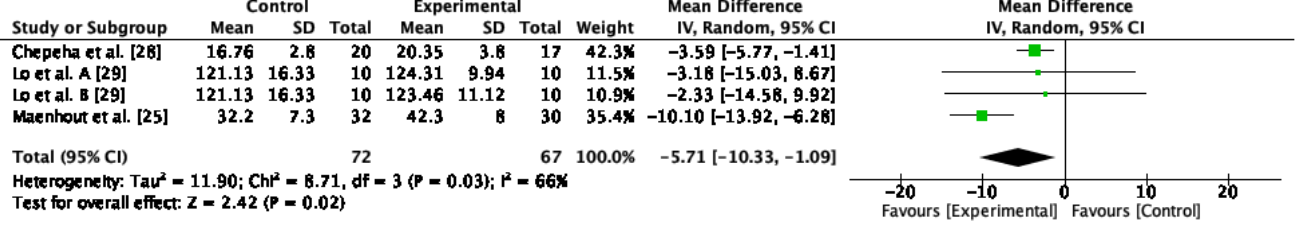
Figure 5. Forest plot of adduction ROM for conservative therapy versus control/sham and conserva- tive therapy versus other conservative therapy. Lo et al. A compared KT versus control intervention. Lo et al. B compared stretching versus control intervention.